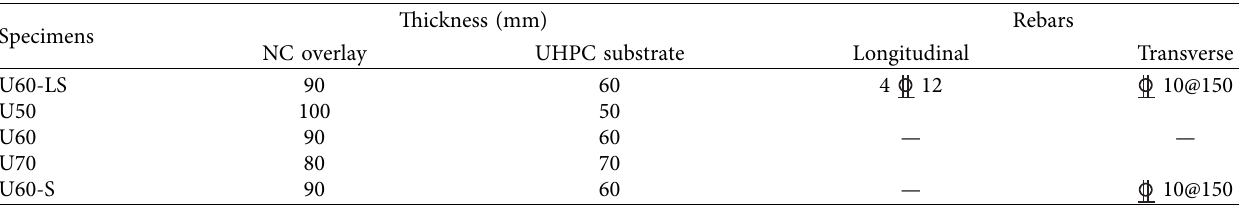
Figure 1: Probable application for NC-UHPC composite bridge decks. (a) Beam bridge. (b) Arch bridge. (c) Cable stayed bridge. (d) Suspension bridge. Table 1: Dimensions and reinforcing